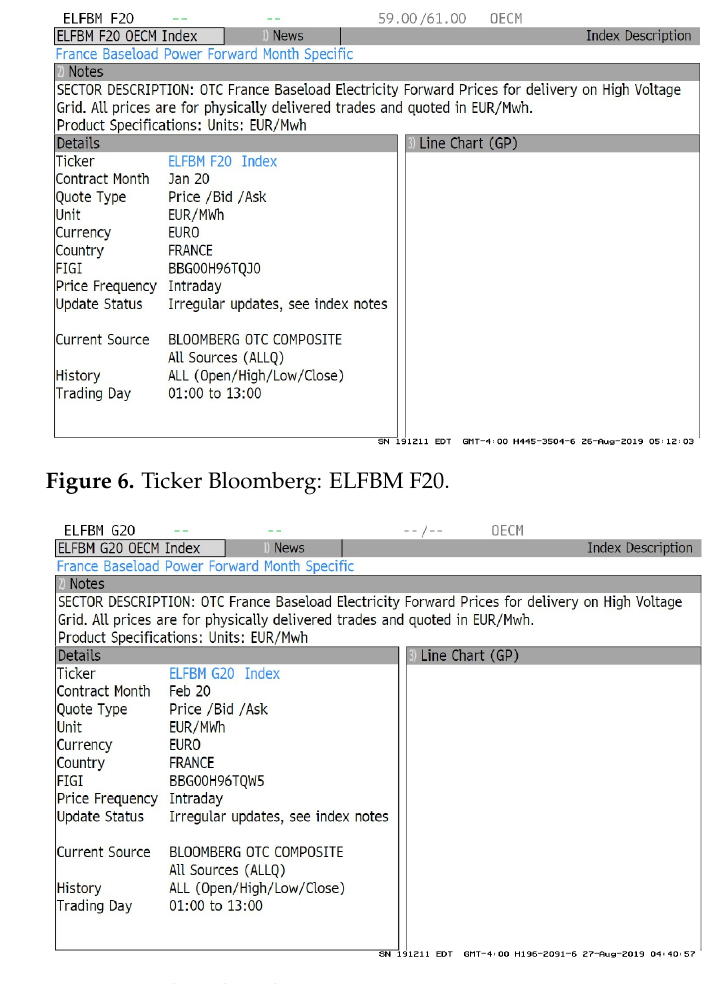
Figure 7. Ticker Bloomberg: ELFBM